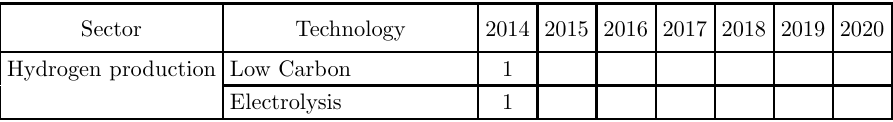
Patent registrations in technology of fuel cells and hydrogen production in Slovak